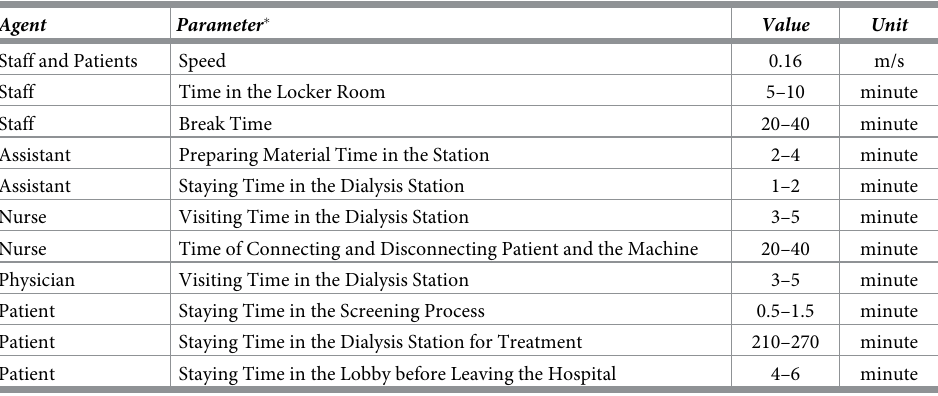
Table 4. Parameters used in the agent-based simulation.